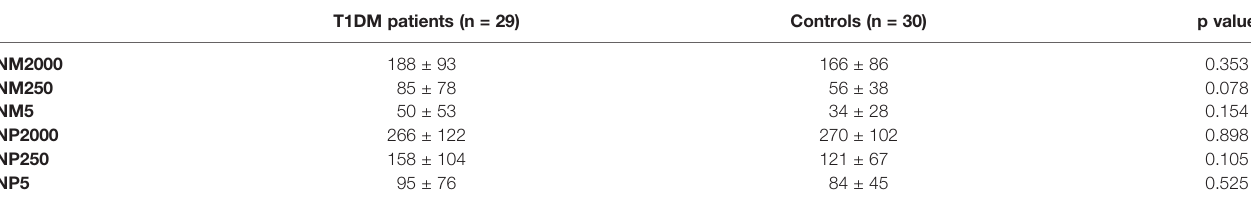
TABLE 5 | Peripheral sensory function testing by Neurometer ® assessing the threshold of the current sensations at the median and peroneal nerves at three different stimulating frequencies (2000, 250, and 5 Hz).